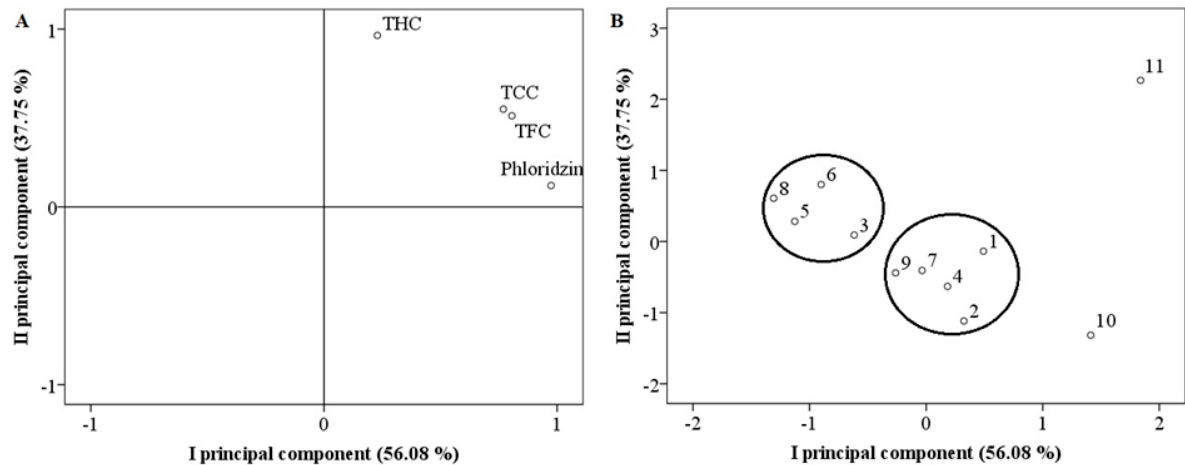
Figure 6. Principal component analysis: loading ( A ) and score ( B ) plots of fruit samples of different Rosa L. species. THC— total content of hydroxycinnamic acid; TCC—total content of flavan-3-ols; TFC—total content of flavonols. 1— R. rugosa cultivar “Dart’s Defender”; 2— R. rugosa cultivar “Adam Chodun”; 3— R. rugosa cultivar “Kornik”; 4— R. rugosa cultivar “Marie Bugnet”; 5— R. pimpinellifolia cultivar “Single Cherry”; 6— R. pimpinellifolia cultivar “Papula”; 7— R. canina; 8— R. rugosa cultivar “Rudolf”; 9— R. rugosa cultivar “Fru Dagmar Hastrup”; 10— R. multiflora ; 11— R. multiflora cultivar “Nana”.